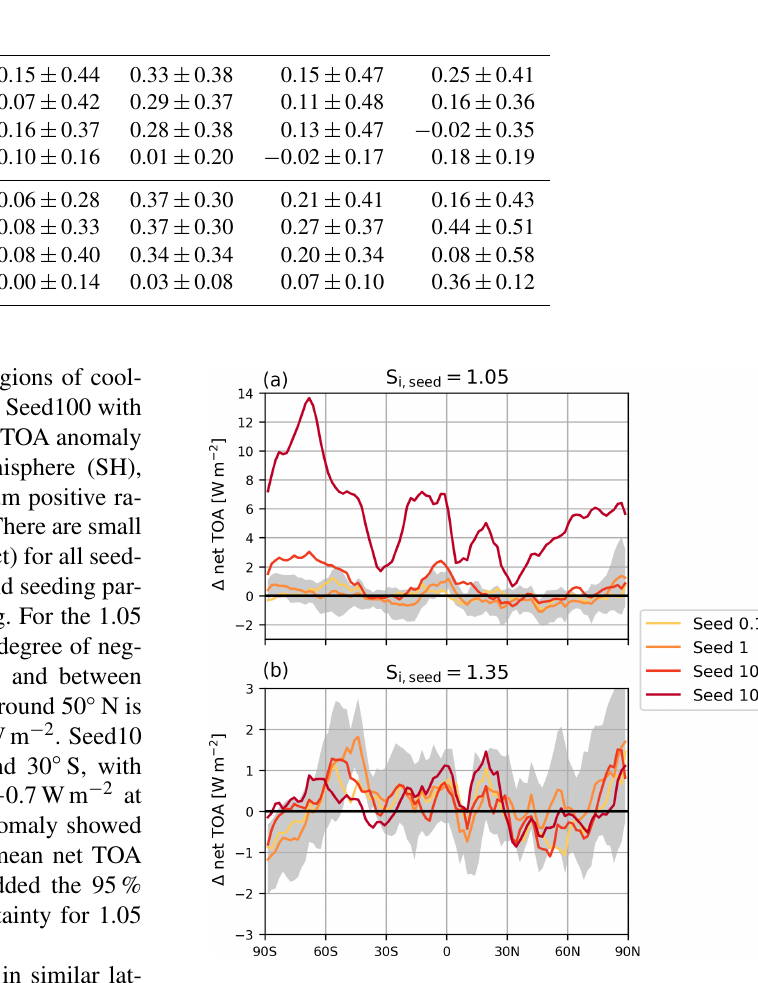
Figure 9. Five-year zonal mean net TOA radiative balance anoma- lies in Wm − 2 between total SW and LW fluxes for a critical seeding particle saturation ratio of (a) 1.05 and (b) 1.35 for each seeding par- ticle concentration minus the reference unseeded D19 simulation. The grey-shaded area is the 95% confidence interval, representing the 2 standard deviation interval, of the Seed1 anomaly based on the variance of the 5-year data. Please take note of the different scales in panels (a) and (b)